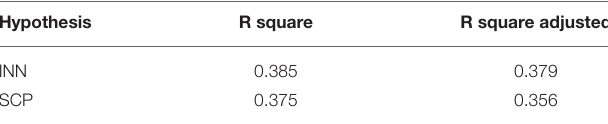
TABLE 9 | The predictive relevance of the model supply chain performance and innovation ( N = 208).